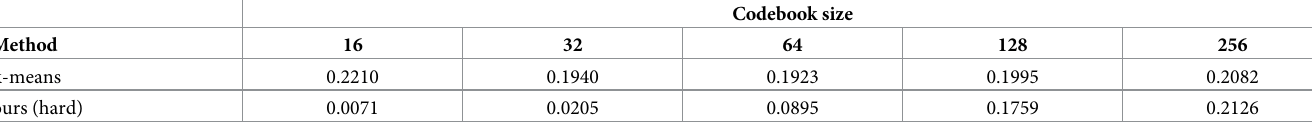
Table 6. The objective values of the k-means and ours with the hard objective with respect to the codebook size on the